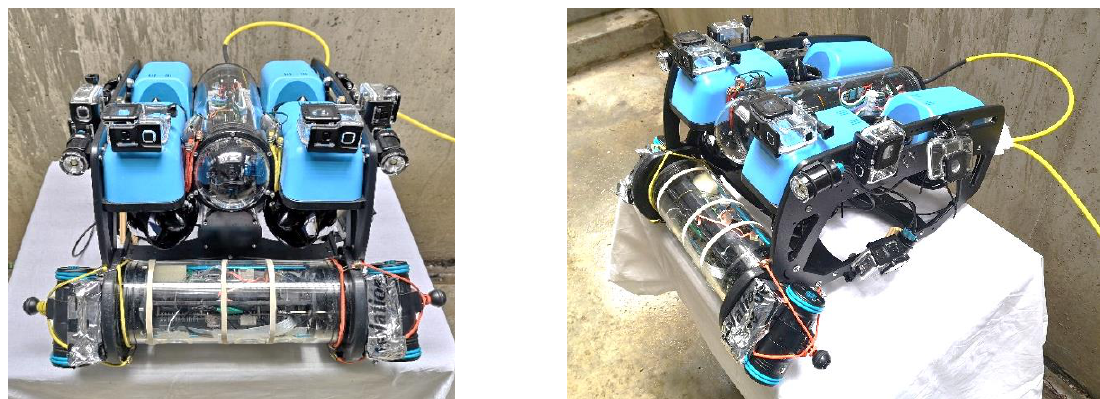
Figure 1. The BlueRov2 fully equipped for underwater cave exploration